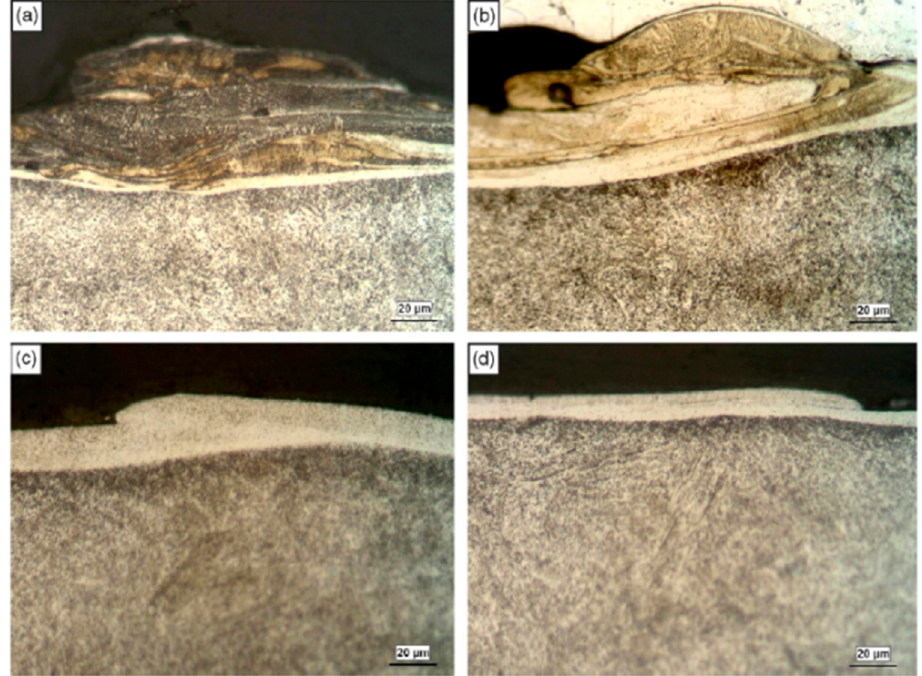
Figure 10. Cross-sectional micrographs of electric discharge machined surfaces ( a ) using kerosene dielectric and graphite electrode, ( b ) using kerosene dielectric and copper electrode, ( c ) using de-ionized water dielectric and graphite electrode, and ( d ) using de-ionized water dielectric and copper electrode [184].